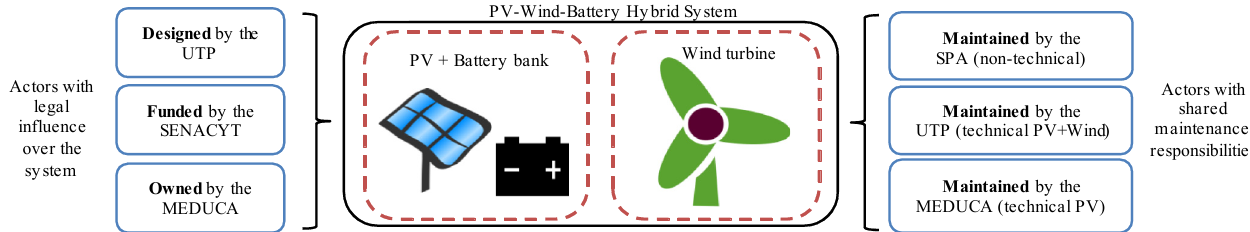
Fig. 3. Decision making structures for the Boca de Lura